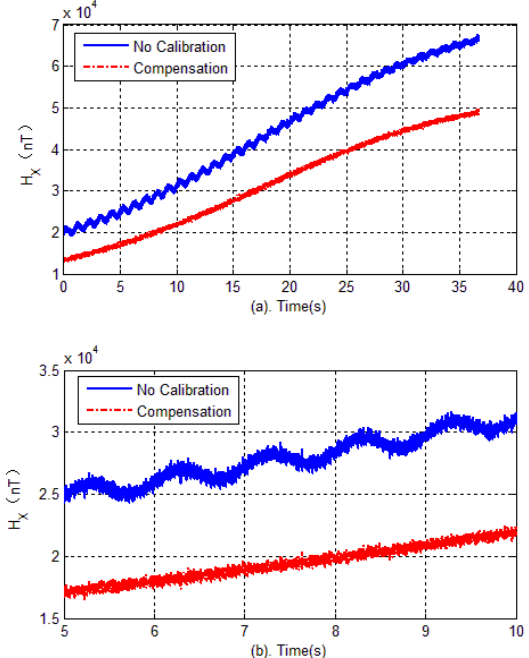
Figure 20. Magnetometer outputs of X-axis. Figure 21. Magnetometer outputs of Y-axis.